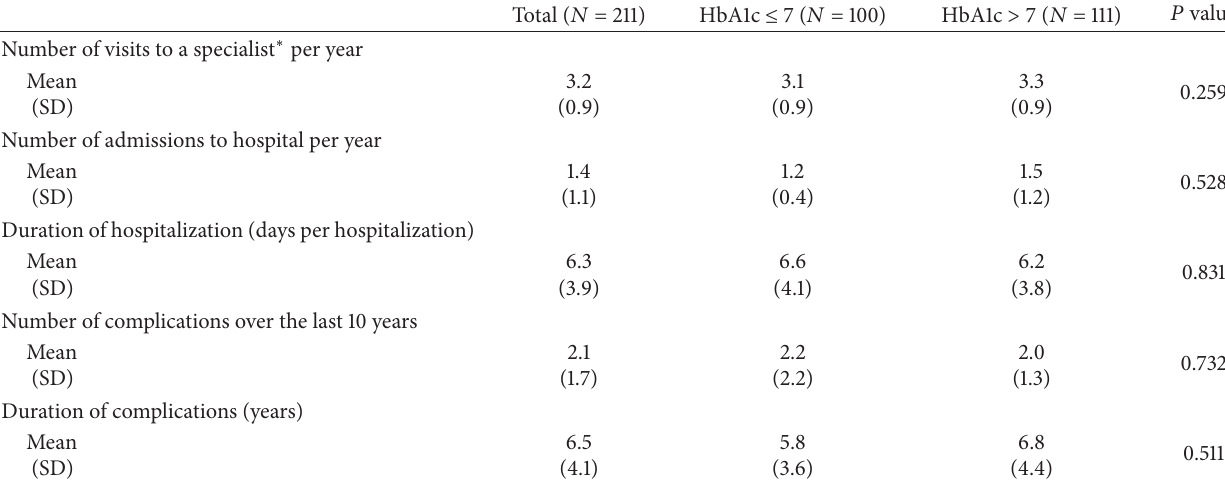
Table 4: Resource use associated with hospitalization, complications, and medical